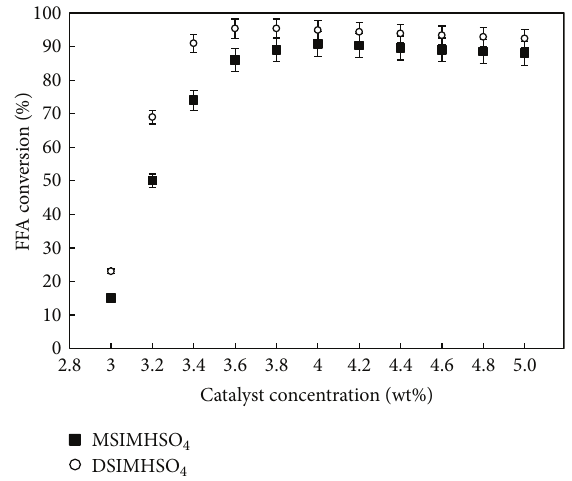
Figure 8: FFA conversion yield versus IL concentration. The reaction conditions were 12: 1 methanol/CCO molar ratio, 150 ∘ C, and 600rpm for 3 h.